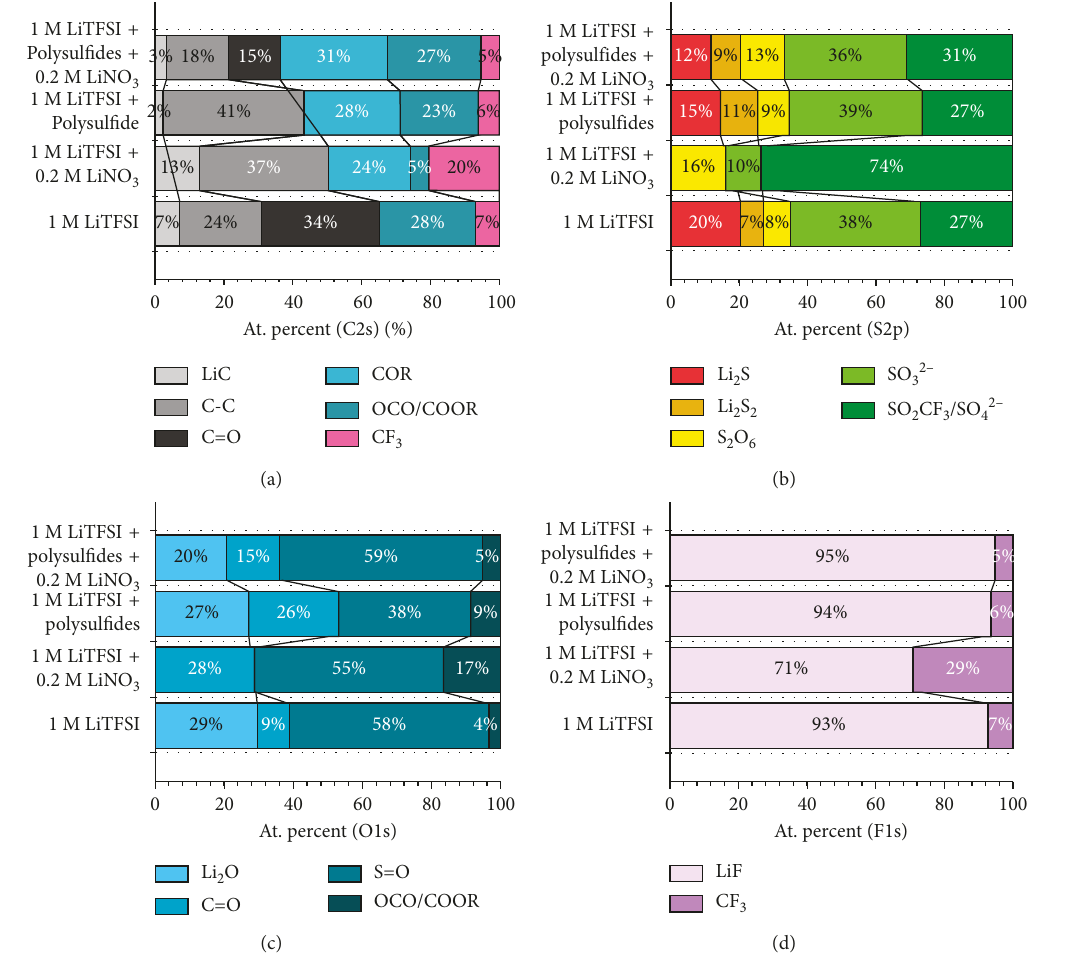
Figure 5: Relative distribution of carbon (a), sulfur (b), oxygen (c), and fluorine (d) containing chemical structures, detected after 30min of sputtering with Ar + for the SEI layers formed by spontaneous passivation.